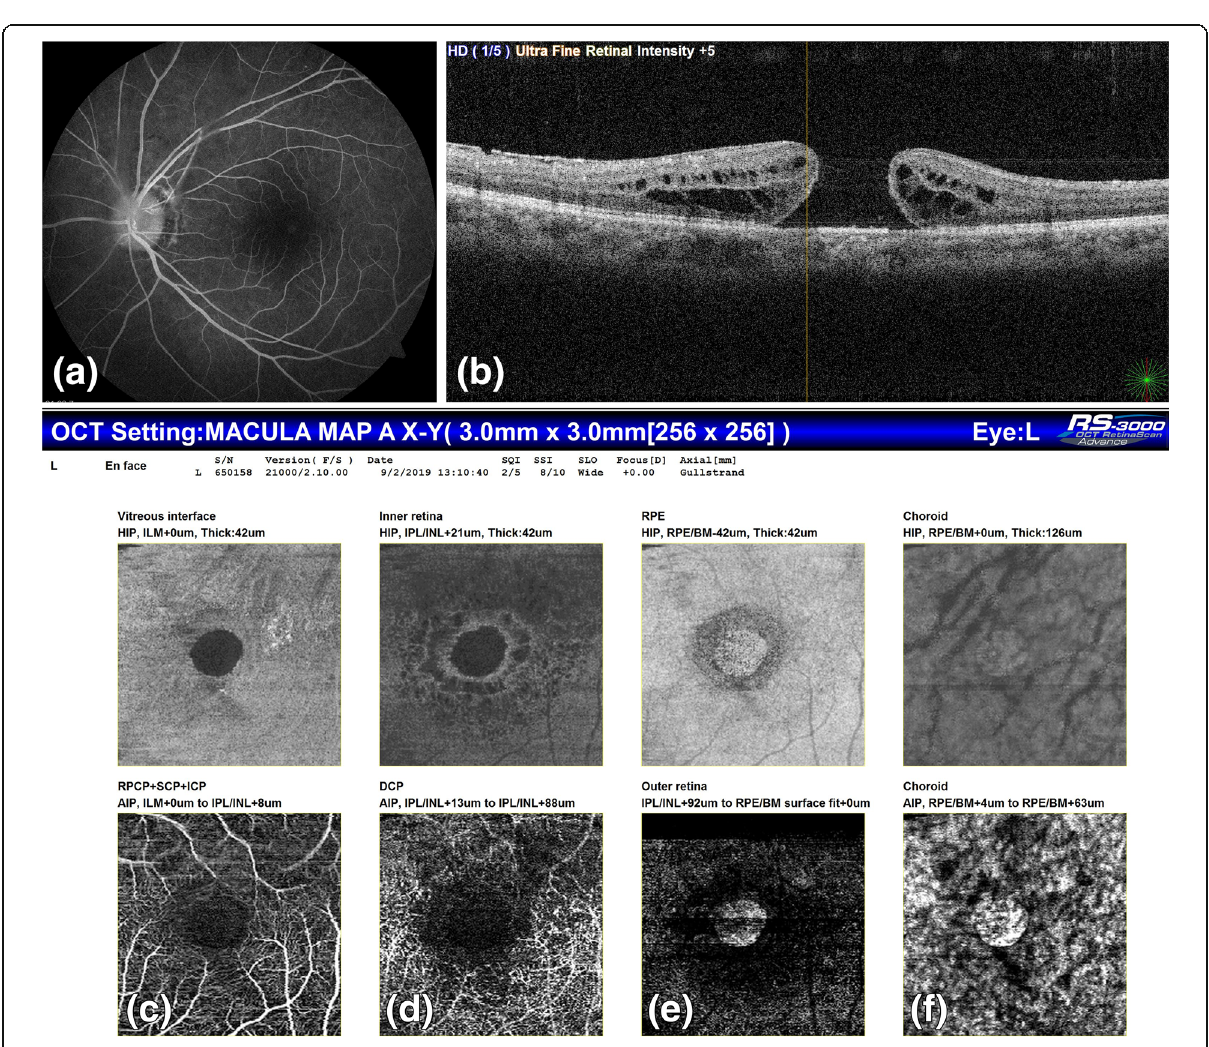
Fig. 2 36 years old male with vision in left eye counting finger 3 m; (a) FA: window defect at macula due to FTMH (b) OCT: shows FTMH with cuff of fluid (c) OCTA at SCP (d) OCTA at DCP (e) OCTA at outer retina (f) OCTA at choroid level shows FTMH with back